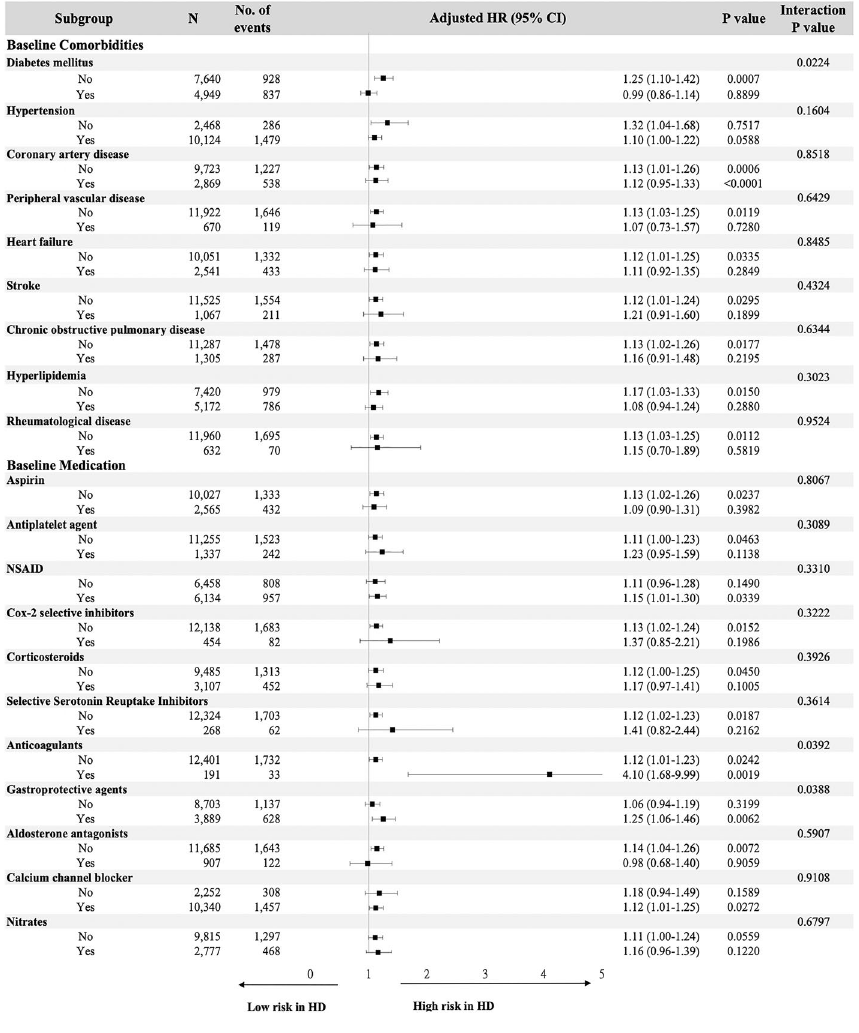
Figure 3. Stratified analysis of risk for gastrointestinal bleeding in matched patients undergoing hemodialysis and peritoneal dialysis using a multivariable subdistribution hazard